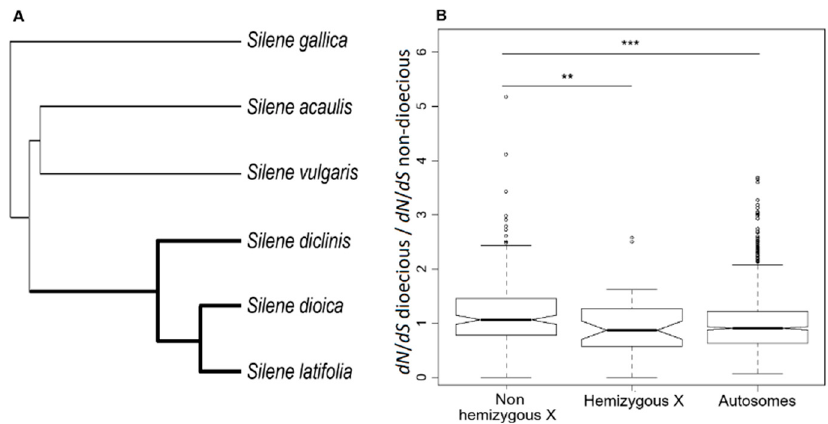
Figure 2. Phylogeny-based analyses of substitution rates. ( A ) The topology of the phylogenetic tree used in the analyses. All nodes had 100% bootstrap support. The “foreground” branches representing the dioecious clade are shown as thick lines. The “background” branches representing non-dioecious species are shown as thin lines. ( B ) Relative change in dN / dS ratio in the dioecious compared to non-dioecious species estimated in the branch analysis allowing separate dN / dS ratios for the “foreground” and “background” branches of the tree shown in panel A. The significance (** p < 0.01; *** p < 0.001) of the differences between the distributions of values in the panel B was tested with the Student’s test.